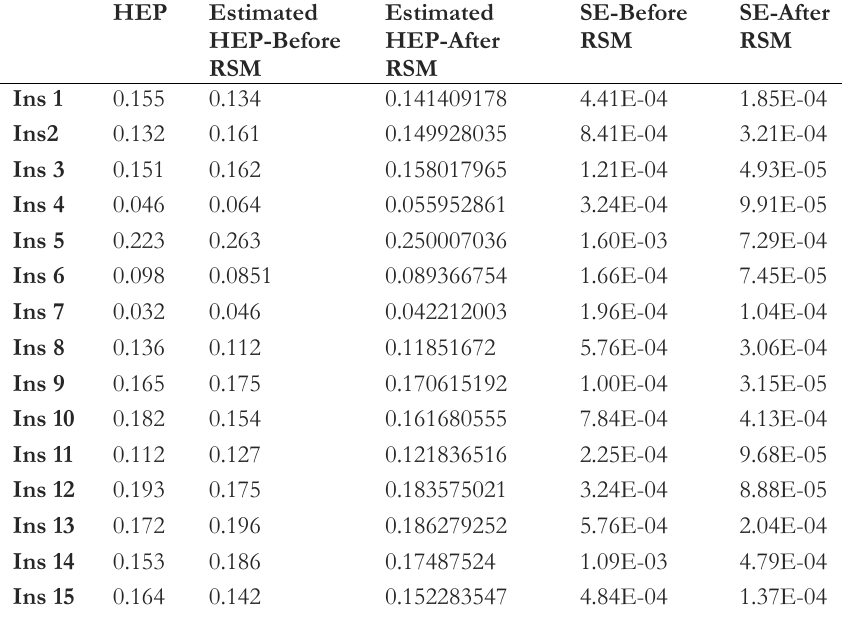
Table 6. The result of ANN after RSM